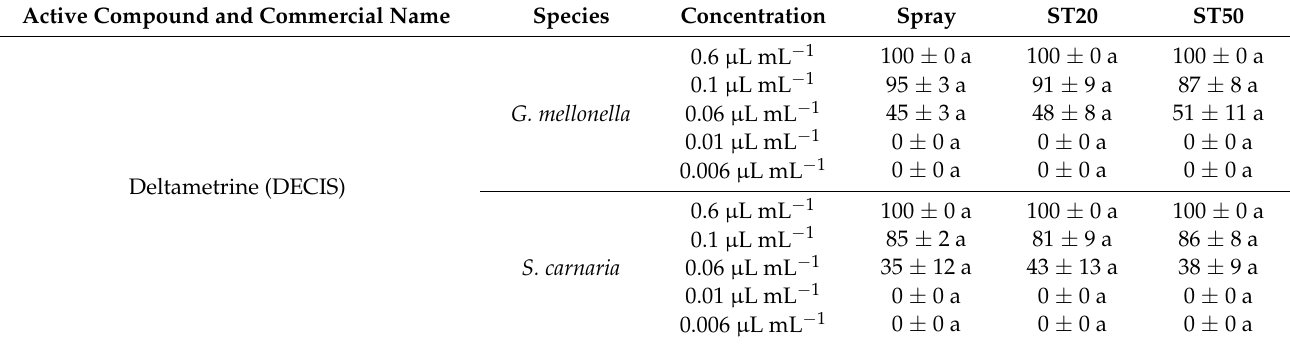
Table 2. Percentage of G. mellonella and S. carnacia larvae that died following treatment with five concentrations of deltametrin by spray system, ST20, and ST50. Data are means ± standard deviation; different letters indicate statistically significant differences within concentration (Duncan’s